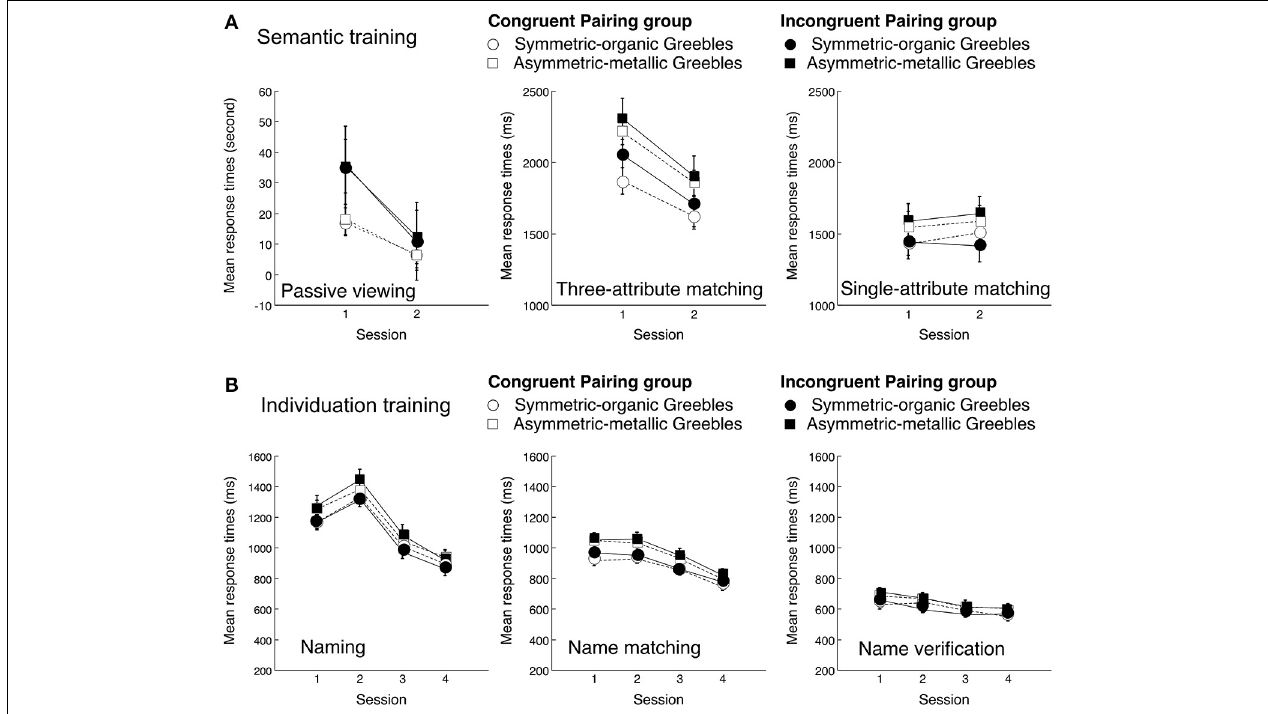
FIGURE 3 | Mean response times in the various tasks of (A) semantic training and (B) individuation training. Note that RT was in seconds in the Passive viewing task and in milliseconds in all